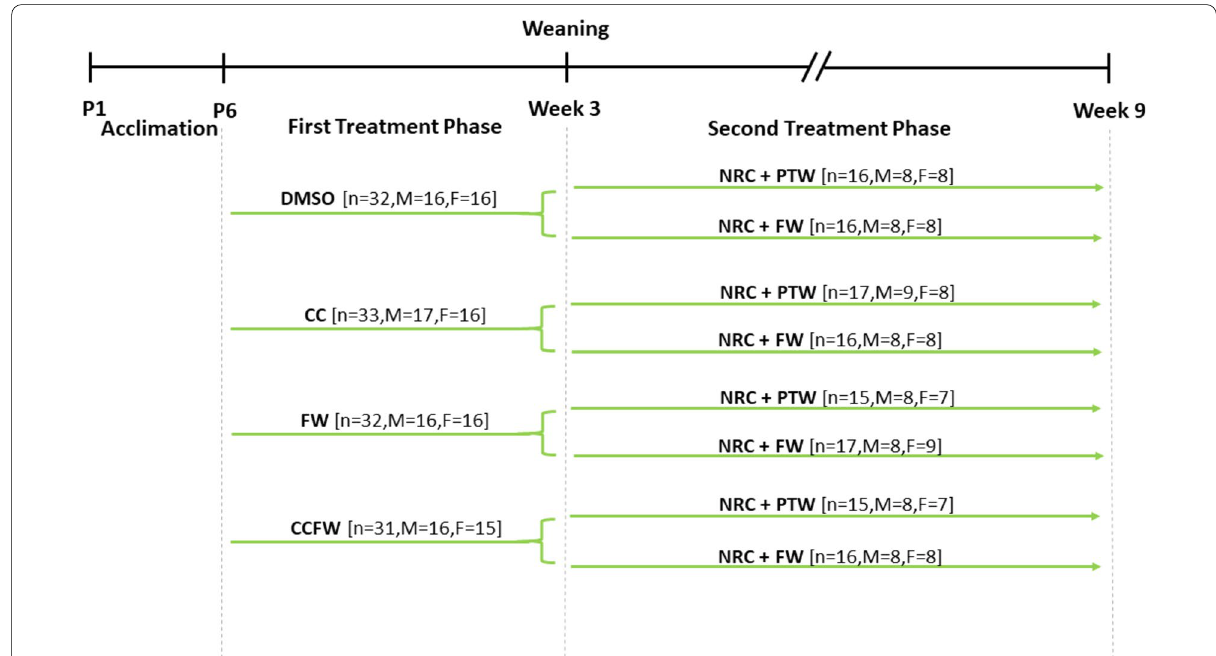
Fig. 1 Schematic diagram of the study design. DMSO, 10 ml kg − 1 of 0.5% dimethyl sulphoxide; CC, 500 mg kg − 1 curcumin; FW, fructose (20%, w/v); NRC, normal rat chow; PTW, plain tap water; M, males; and F,